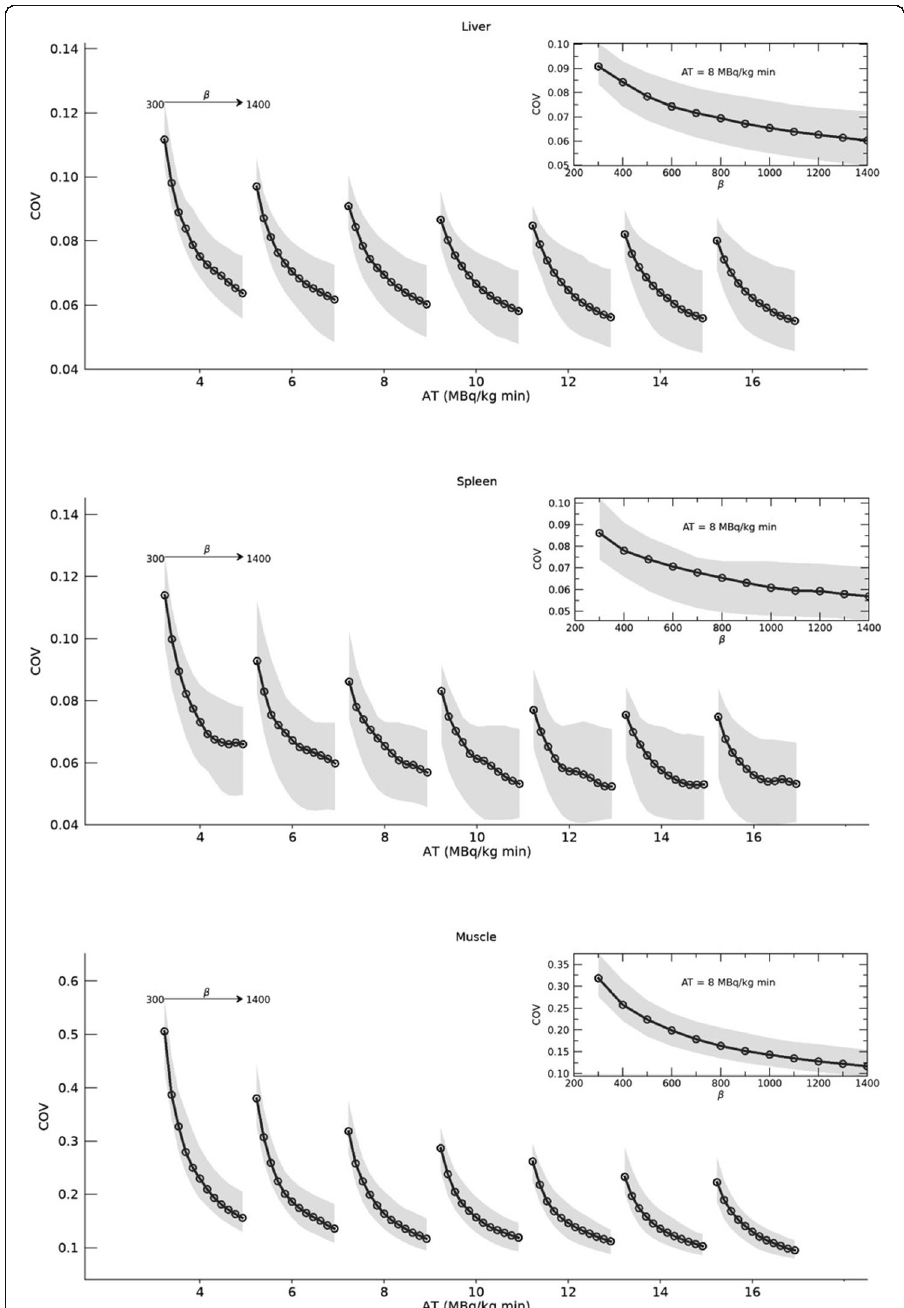
Fig. 1 Image noise levels . Coefficient of variation (COV) in liver, spleen, and muscle ROIs, as a function of β value and activity time product (AT). The solid black line with circles represents the median of all patients ( n = 33) and the grey shaded area shows the 25th – 75th percentile range. The inserts show detailed views for AT = 8